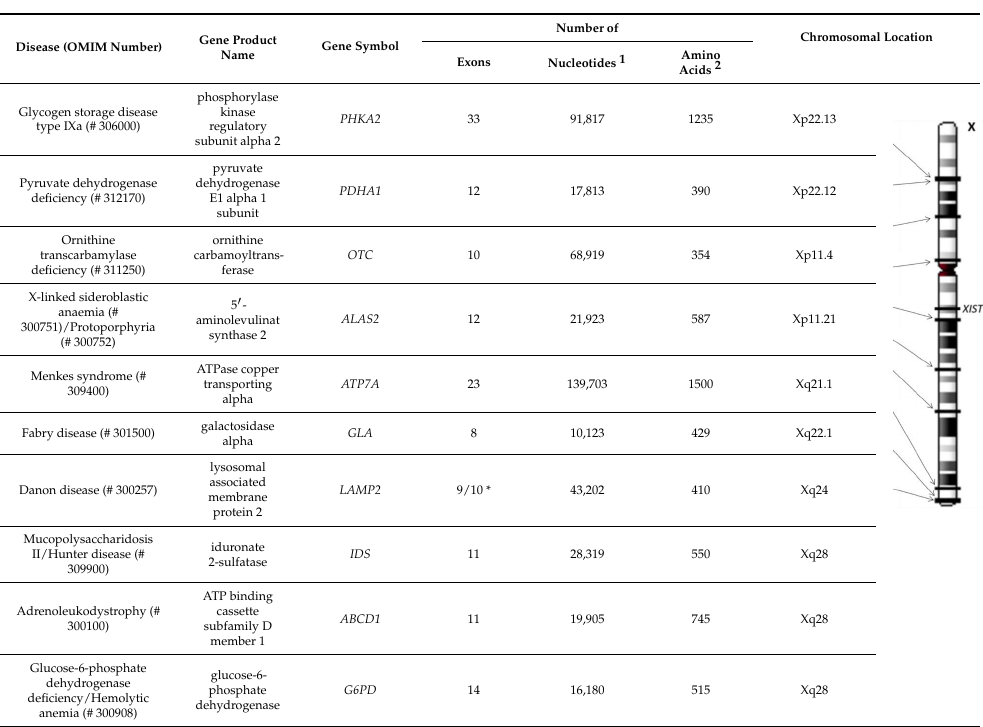
Table 1. Characteristics of genes whose mutations are associated with the disorders described in this review.